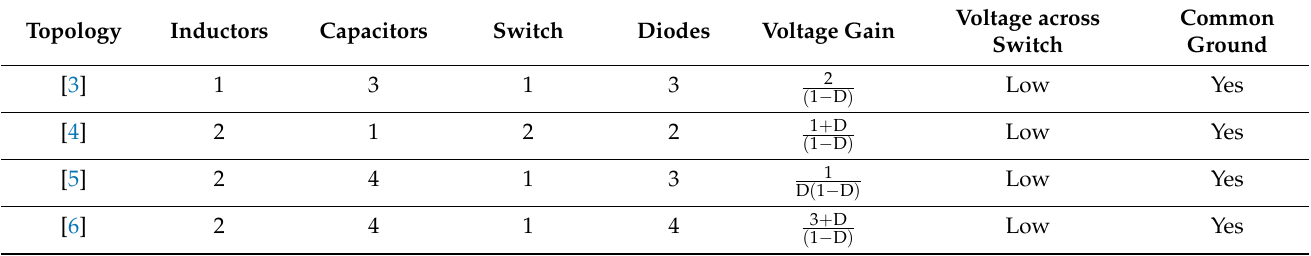
Table 1. Characteristic features of the converters discussed in the